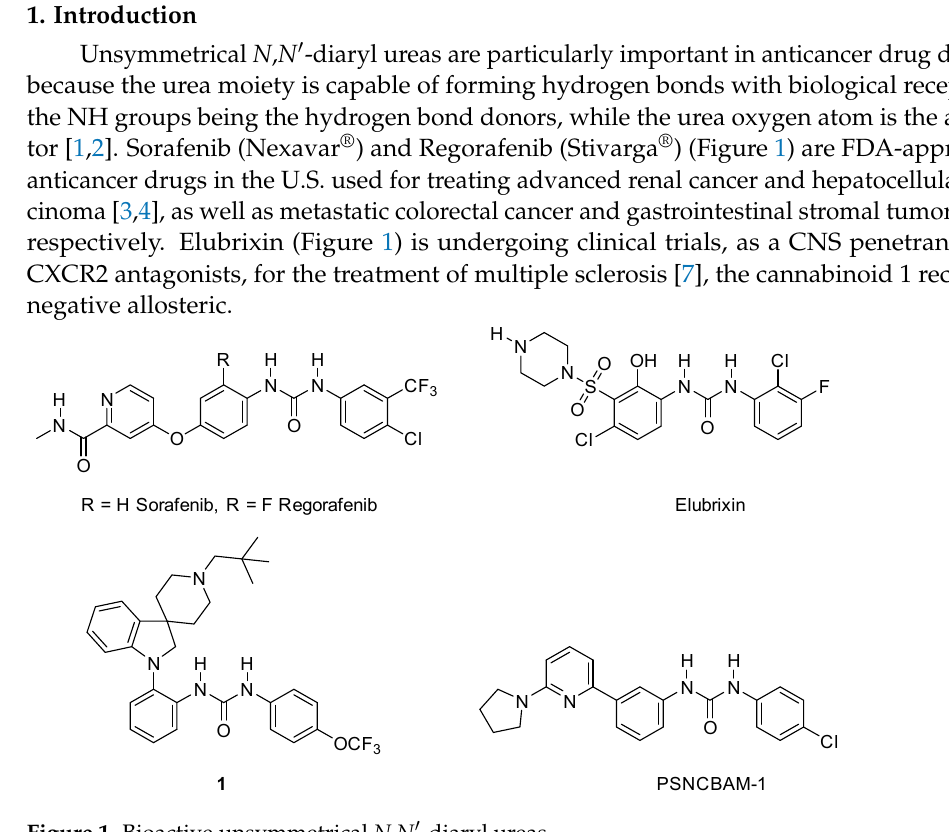
Figure 1. Bioactive unsymmetrical N , N ’-diaryl ureas.